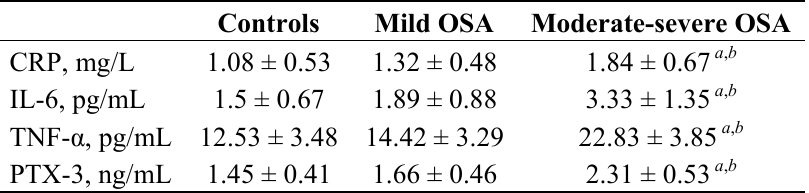
Table 2. Comparison of hsCRP, IL-6, TNF- α , and PTX-3 between groups. Controls